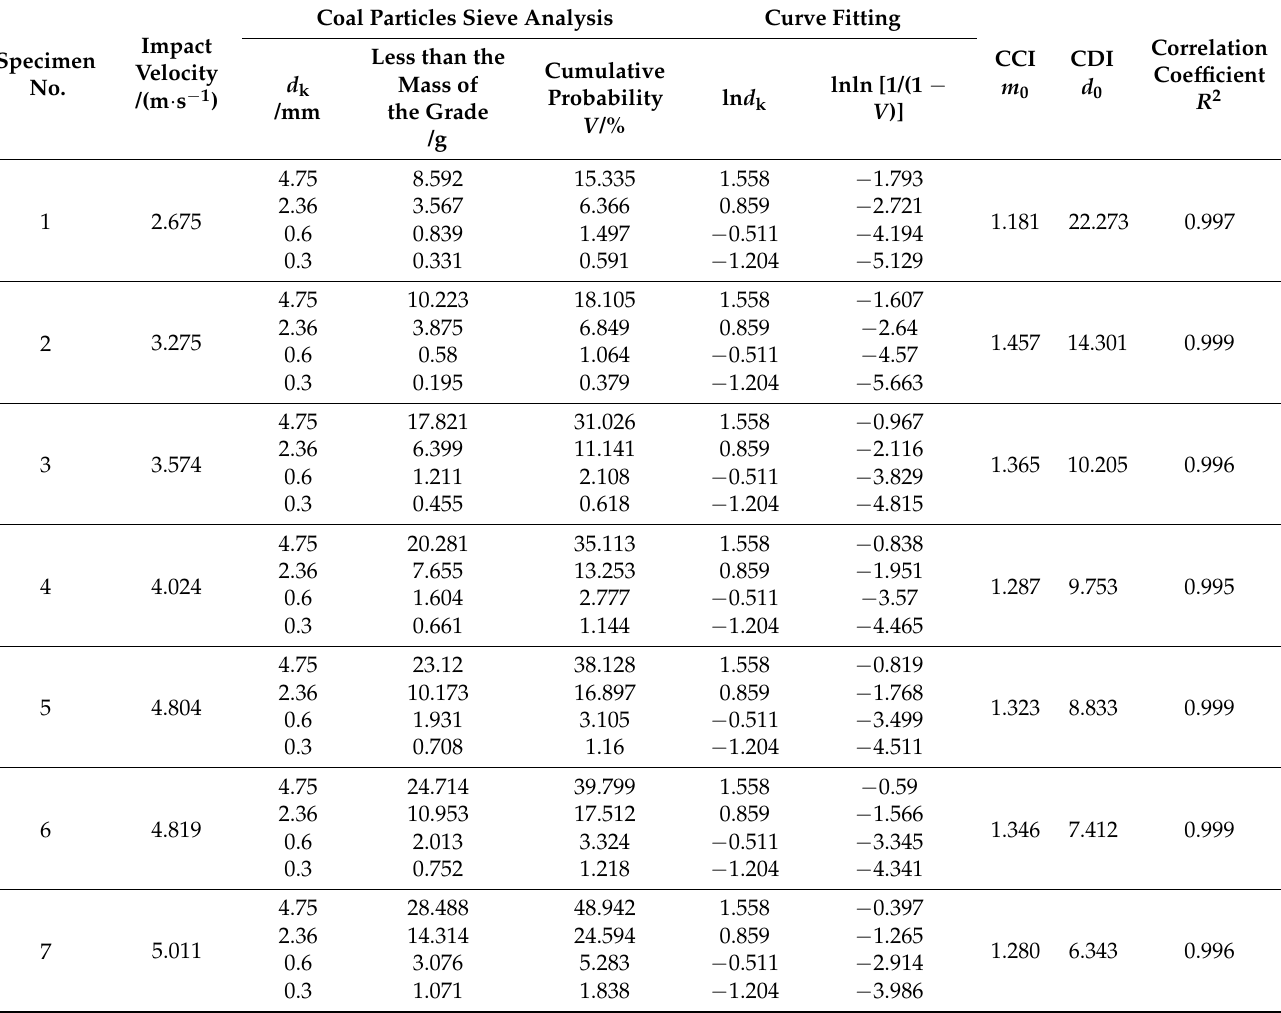
Table 3. The analysis results of coal rock